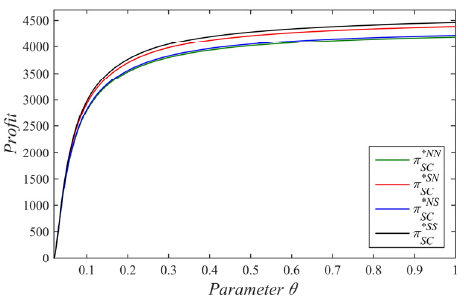
Figure 7. The impact of parameter